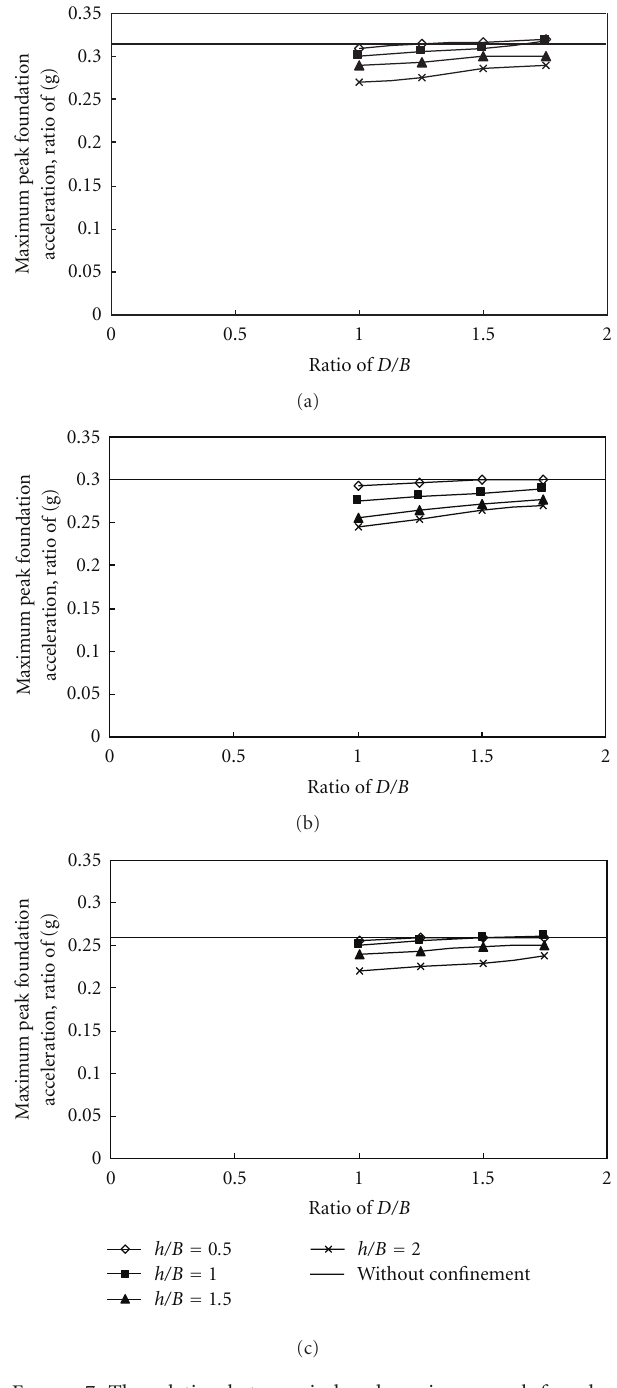
Figure 7: The relation between induced maximum peak founda- tion acceleration and cell geometry at di ff erent